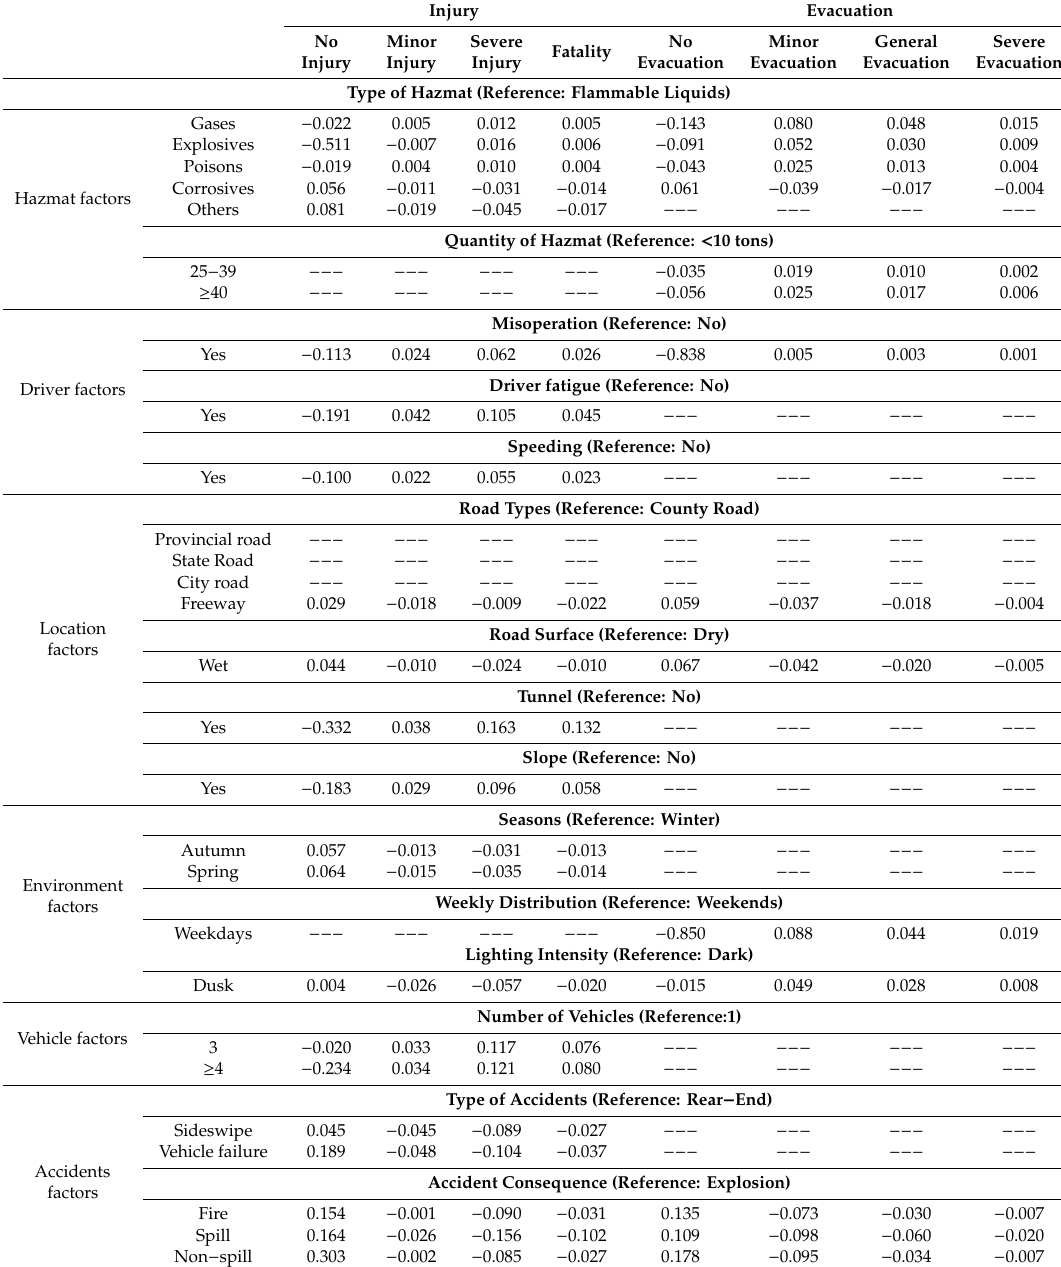
Table 4. Marginal e ff ects of the explanatory